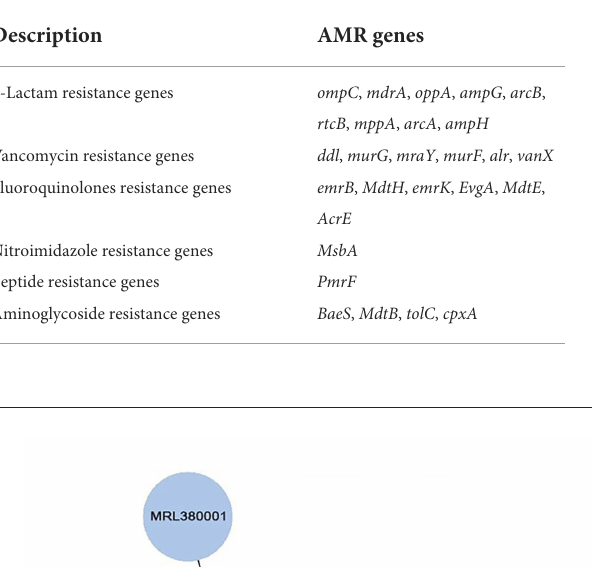
TABLE 4 Summary of resistance genes carried by STEC isolates.